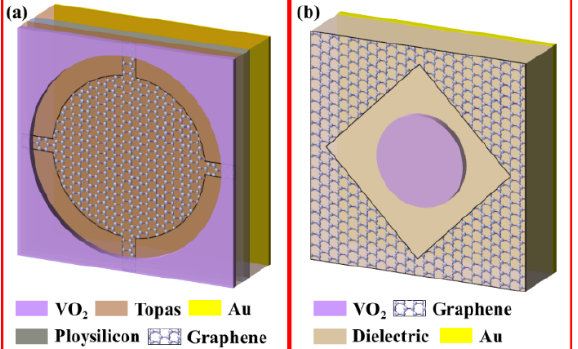
Figure 19. Multi-functional metamaterial structures based on the combination of VO 2 and graphene. ( a ) Realizing absorption with different characteristics [179]; ( b ) realizing absorption and polarization conversion [189].